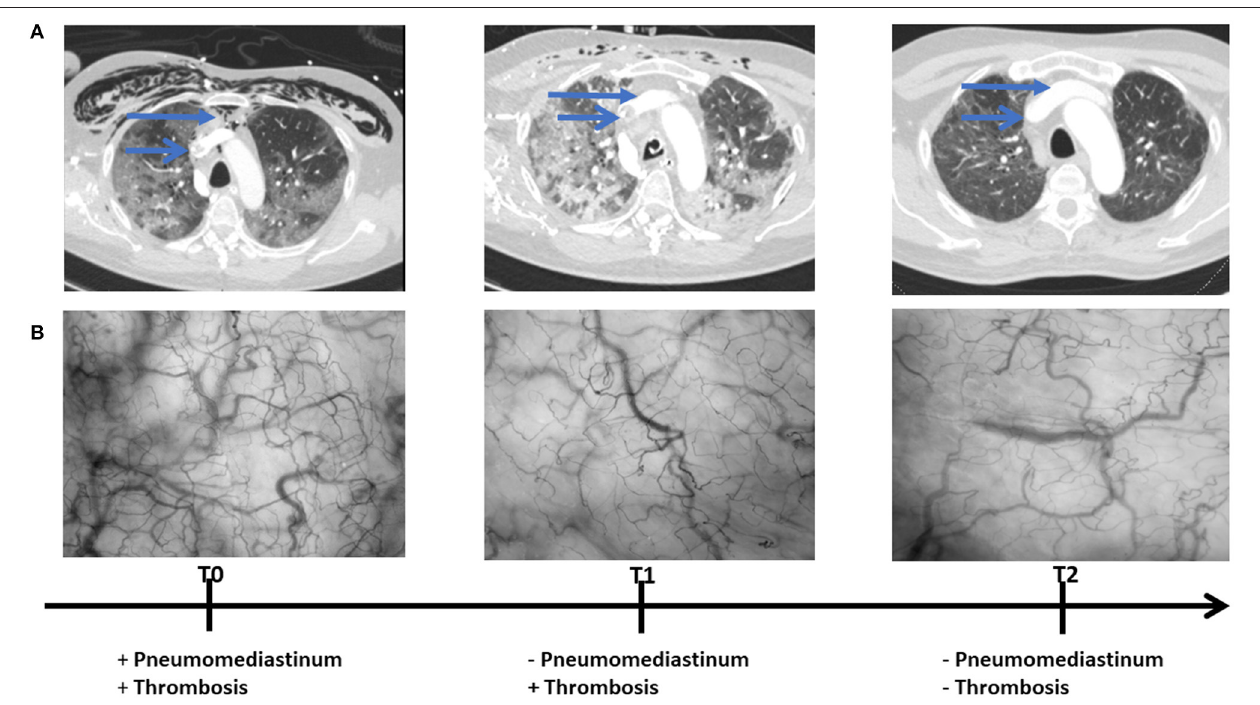
FIGURE 1 | Chest CT (A) and microcirculatory images (B) obtained at 5th (T 0 ), 19th (T 1 ), and 25th (T 2 ) day of intensive care